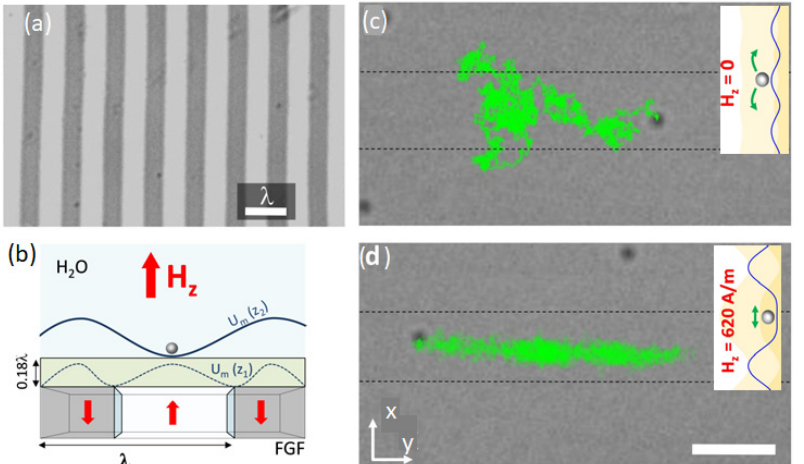
Figure 15. ( a ) Image of a uniaxial ferrite garnet film with magnetic domains having a spatial periodicity λ = 6.8 μ m, visualised due to the polar Faraday effect. ( b ) Domain configuration under applied field. The lines above demonstrate the change in the potential landscape with the distance above the film. ( c , d ) Microscope snapshots of the trajectories of one particle with a diameter of 360 nm without the field and in the presence of the field, respectively. The dashed lines designate the position of the domain walls. Insets show the potential landscapes along y -direction. The scale bar is 5 μ m. Reprinted with permission from ref. [71]. Copyright 2016, American Chemical Society.